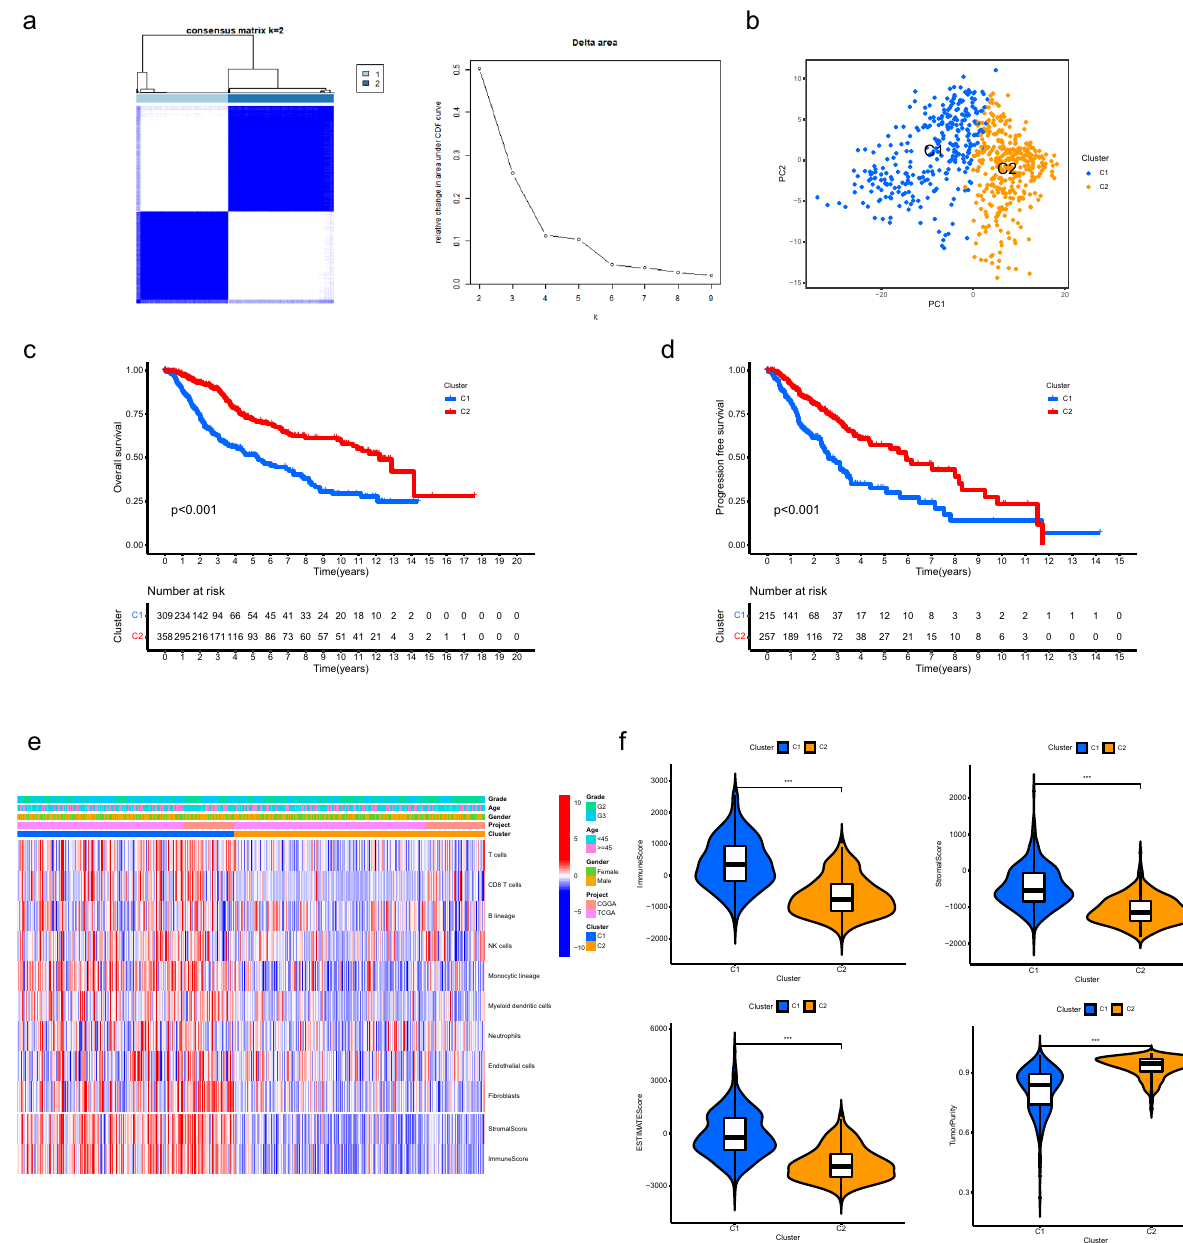
Figure 2. Classification for LGG samples based on the expression patterns of ATMERS. ( a ) Consensus clustering for LGG samples identified two clusters. ( b ) PCA verified the subgroup assignment of LGG samples. ( c ) C1 exhibited significantly shorter overall survival than C2. ( d ) The progression free survival for C1 was significantly shorter than C2. ( e ) Heatmap showing the distinct TME patterns between C1 and C2. ( f ) Comparisons of immune score, stromal score, ESTIMATE score and tumor purity between C1 and C2. * means p < 0.05, ** means p < 0.01, and ***means p < 0.001. LGG, low-grade glioma; ATMERS, aging tumor microenvironment related signature; PCA, principal component analysis; TME, tumor (Fig. 3h). The proportion of LGG patients with disease free status in the low aging TME score group was sub- stantially higher than those in the high aging TME score group (Fig. 3i, p < 0.001). The grade for LGGs in the low aging TME score group was lower (Fig. 3j, p < 0.001). We found more IDH1 mutant LGG samples in the low aging TME score group (Fig. 3k, p < 0.001). LGG patients in the low aging TME score group were more sensitive to conventional treatment (Fig. 3l, p < 0.001). All these findings indicated that LGG patients with low aging TME scores were more likely to get better prognosis.